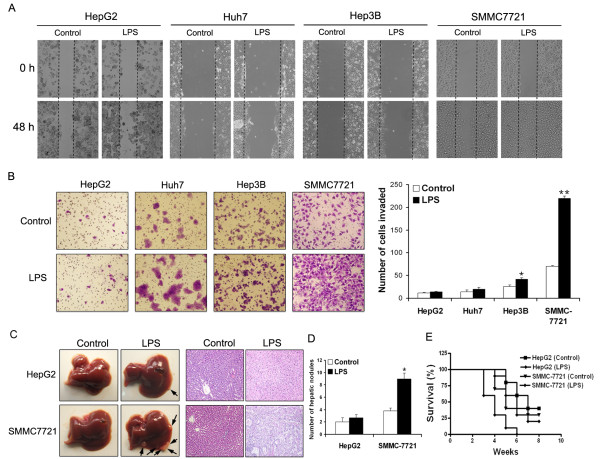
Metastasis and invasion of HCC cells lines in response to LPS. (A) The wound healing assay was employed to determine the migration of HepG2, Huh7, Hep3B and SMMC-7721 cells in response to LPS. Cells were monitored every 24 hours for two days to evaluate the rate of migration into the scratched area. (B) Invasiveness of cells was determined using the Transwell assay. Cells were treated with LPS (10 μg/ml) for 48 hours, and then plated in the upper chamber of the Transwell and allowed to grow for 24 hours in serum-free medium, 5% fetal bovine serum was placed in the lower chamber. The number of cells that invaded through the Matrigel was counted in ten fields under the ×20 objective lens, and is shown as the mean ± standard deviation (*P < 0.05, **P < 0.01). (A) and (B) are representative of at least three independent experiments (× 200). (C) Pictures of metastatic liver nodules in nude mice by splenic-vein injection of HepG2 and SMMC-7721 cells untreated or treated with LPS. H & E staining was performed on serial sections of metastatic tumors and normal liver (× 200). The arrows indicate the metastatic tumor on the surface of the liver. (D) The numbers of nodules were quantified on nude mice livers (n = 10 per group). Values for individual mice are shown above the bars (*P < 0.05). (E) Survival rate of nude mice six weeks after splenic vein injection of HepG2 and SMMC-7721 cells untreated or treated with LPS. HCC, hepatocellular carcinoma; LPS, lipopolysaccharide.